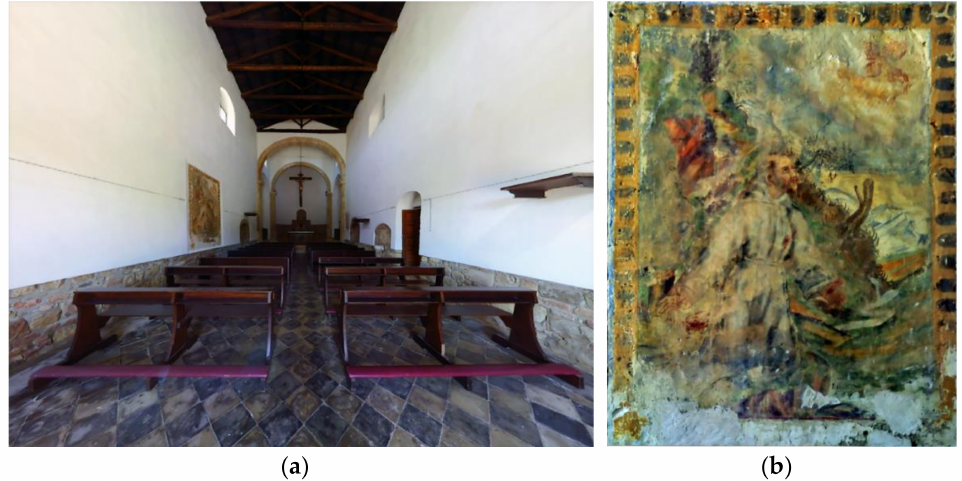
Figure 4. Internal space: view from the main access toward the presbytery ( a ); on the nave left wall, aligned with the secondary access, is still preserved a wall painting depicting St. Francis ( b